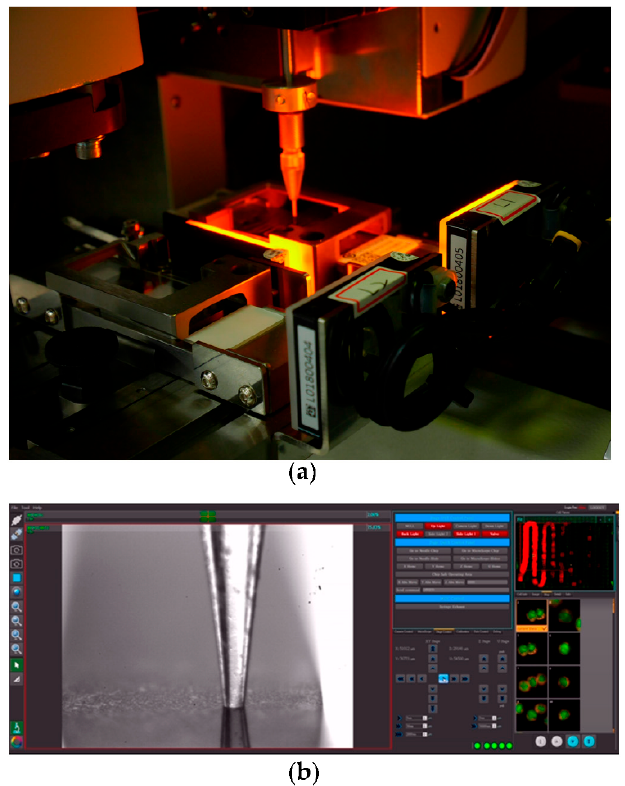
Figure 2. An automated cell retrieval device. ( a ) The cell retrieval platform and capture glass capillary tube. ( b ) Computer assisted cell capture operation. The capture glass capillary tube was monitored with high-resolution camera.